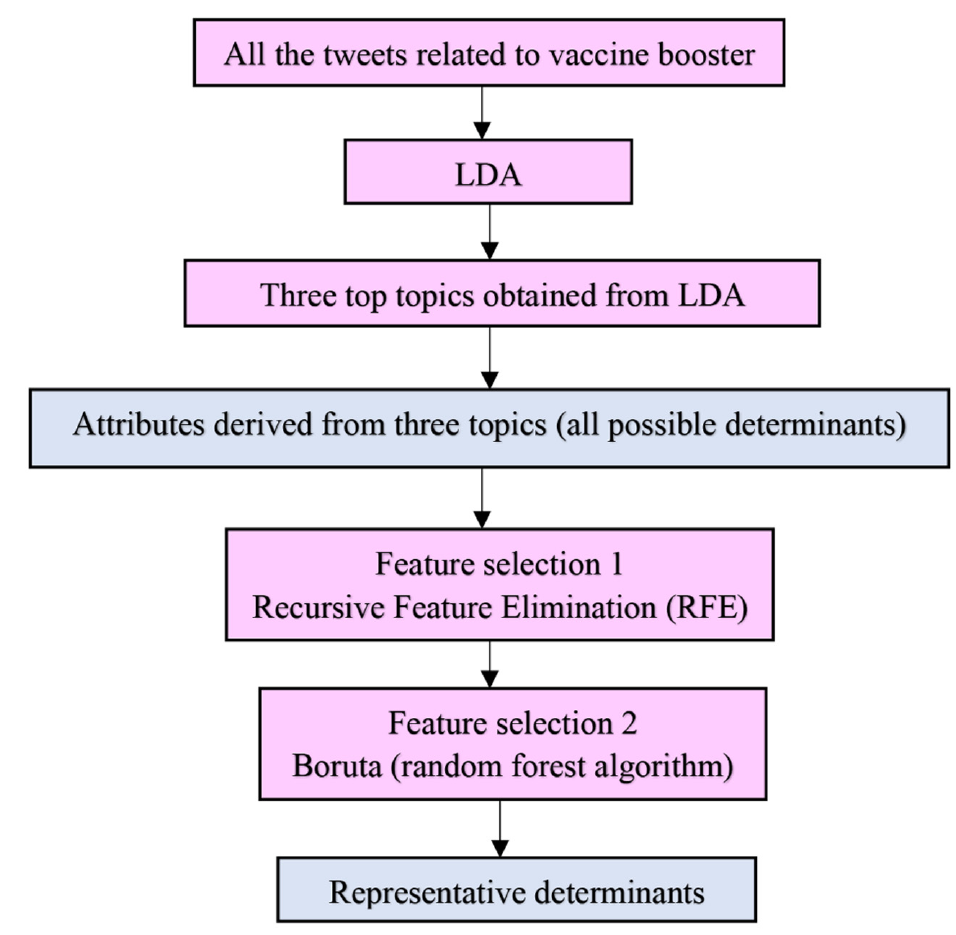
Figure 2. Process of feature assessment